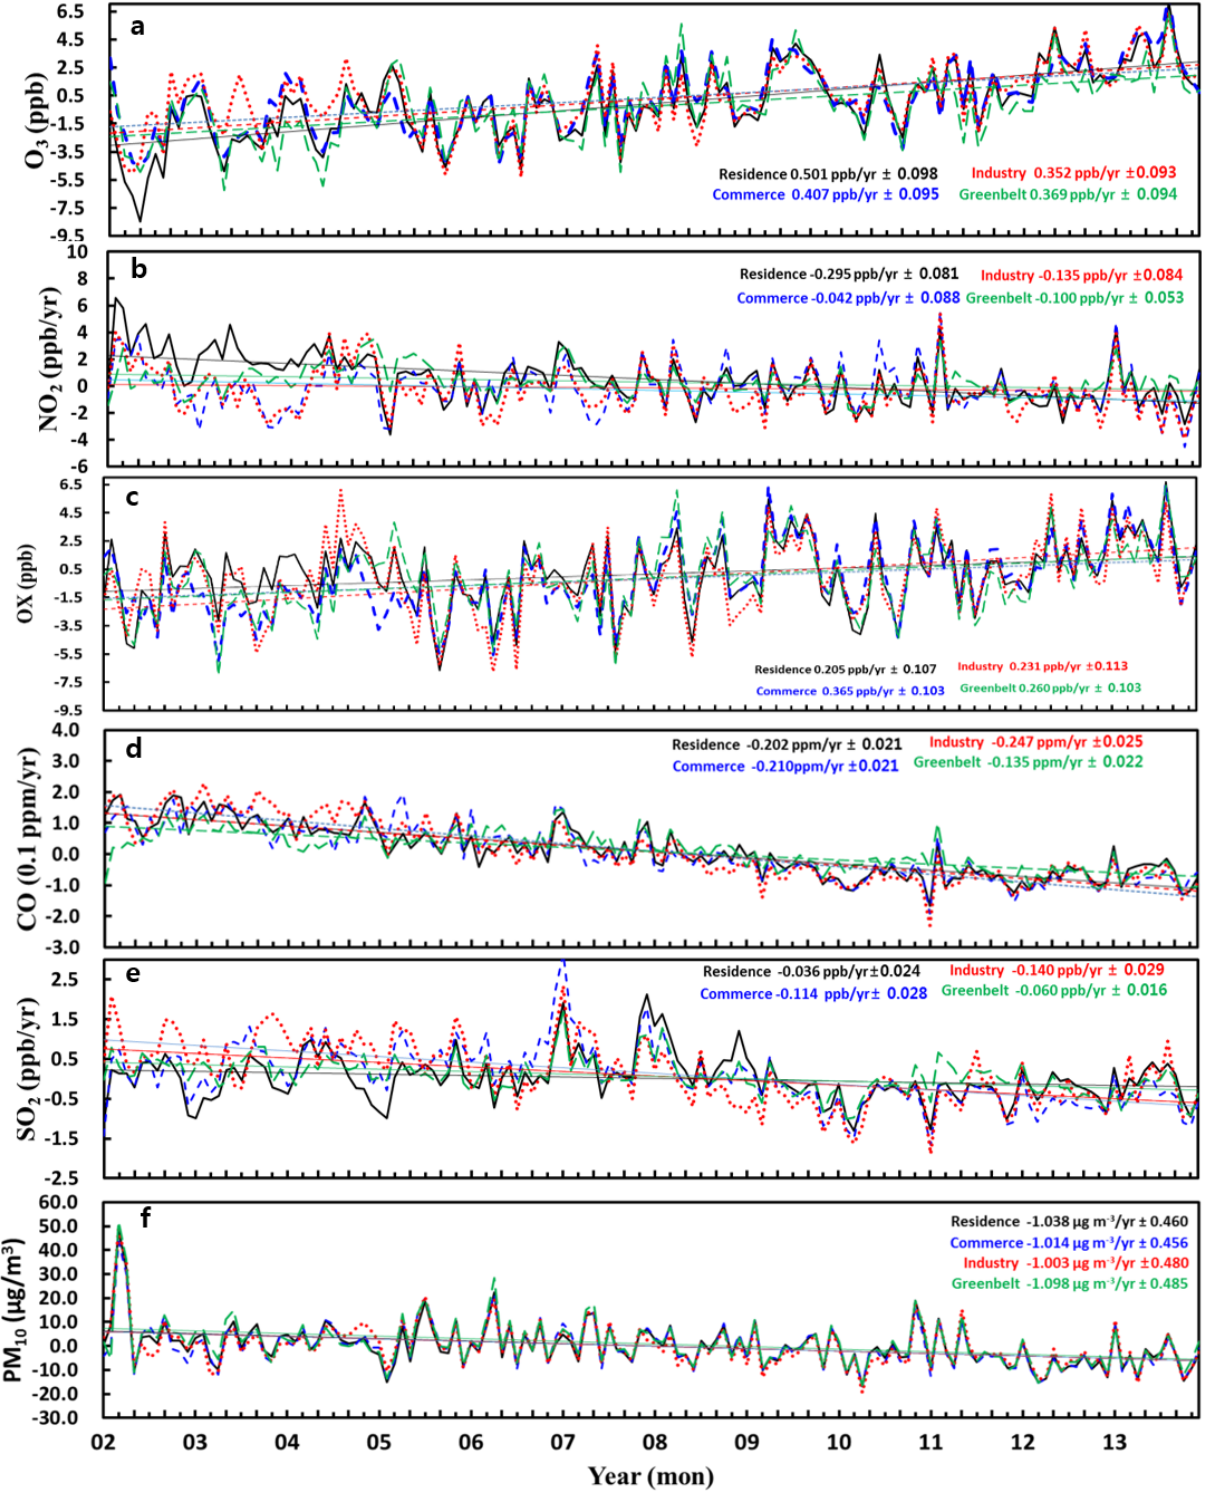
Figure 7. Time series of the monthly surface air pollutant anomalies in a 0.25 ◦ × 0.25 ◦ grid of the (a) O 3 (ppb), (b) NO 2 (ppb), (c) OX (ppb), (d) CO (0.1ppm), (e) SO 2 (ppb), and (f) PM 10 (µgm − 3 ) observations over South Korea during the period from January 2002 to December 2013 under the following MEK land-use types: residence (black solid), commerce (blue dashed), industry (red dotted) and greenbelt (green dashed). The ± trend values define the 95% confidence